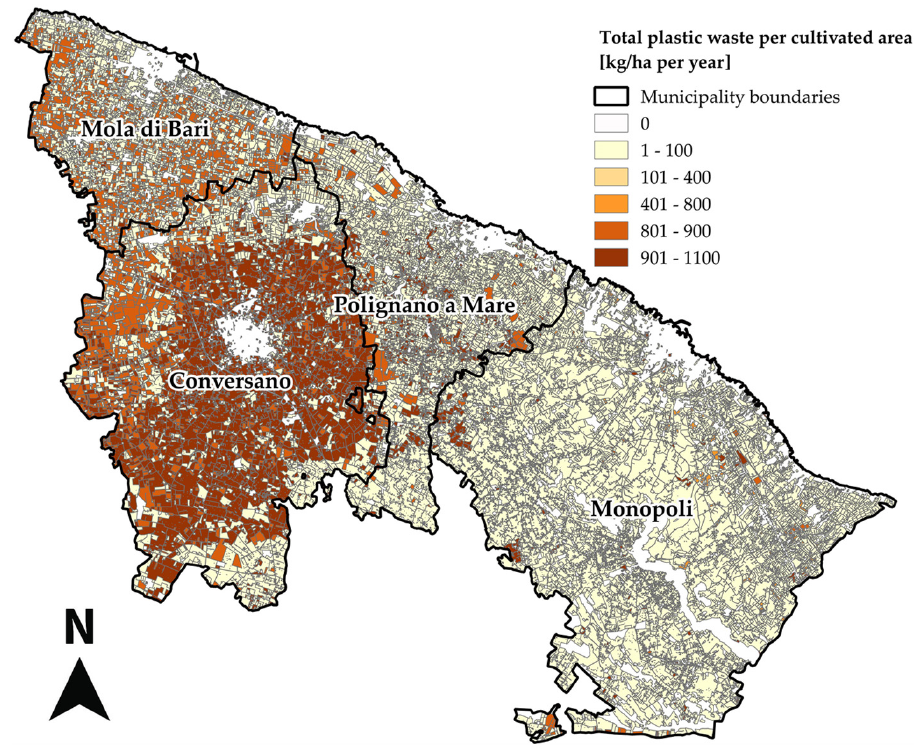
Figure 5. Distribution of the total APW in the four municipalities in the scenario of partial replacement of some of the plastics with bio-based materials (2nd scenario).